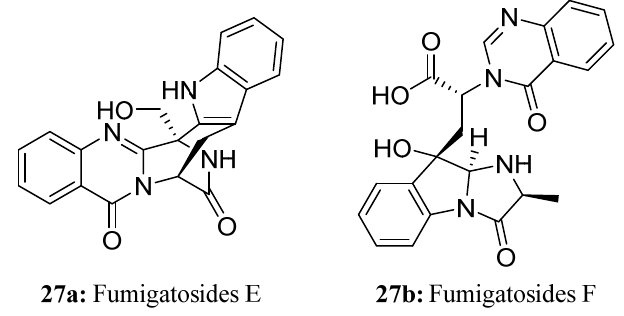
Figure 5. The structure of fumigatosides E and F ( 27a , b ).